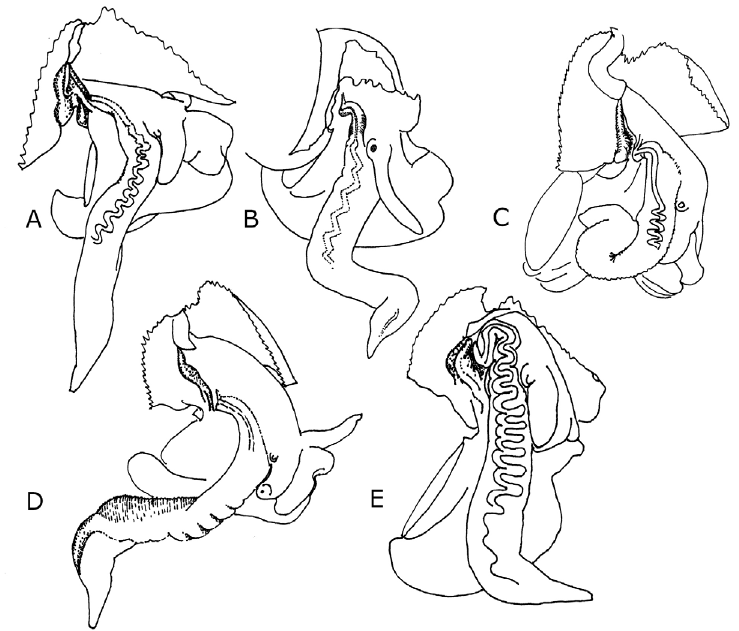
Fig. 16. Comparison of male genitalia. A . Cochlostoma ( Clessiniella ) anomphale Boeckel, 1939. Vellach, Austria (EZ0991). B . Co. ( Cl. ) stelucarum sp. nov., Cornino, Italy (EZ0104). C . Co. ( Cl. ) tergestinum (Westerlund, 1878), Val Rosandra, Italy (EZ0840). D . Co. ( Cl. ) villae (Strobel, 1851), Mizzole, Italy (EZ0878). E . Co. ( Cl. ) waldemari (A.J.Wagner, 1897), Tisovec, Croatia